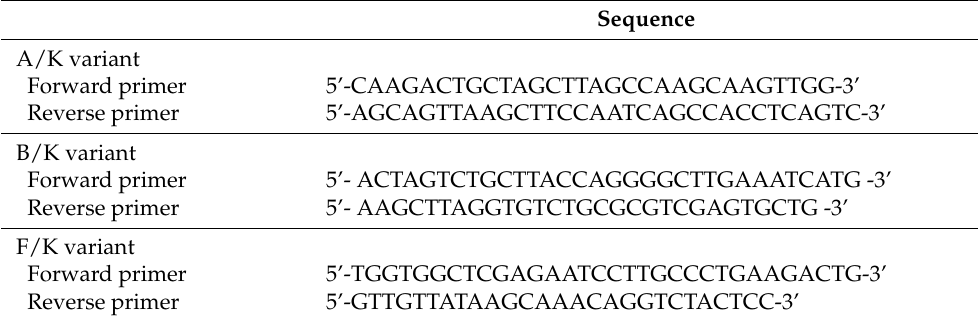
Table 2. Oligonucleotide primers used for cloning of promoter.